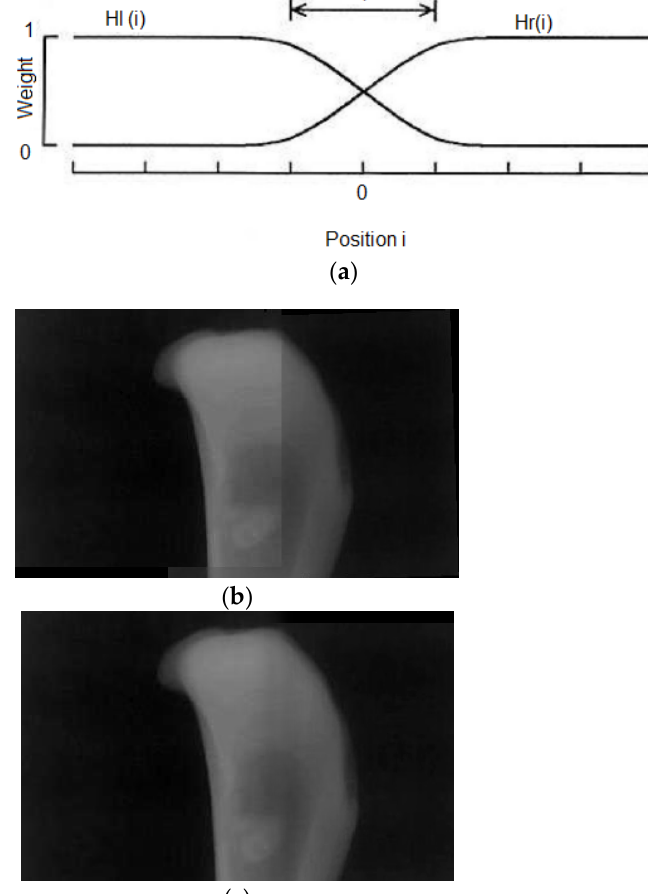
Figure 5. Image stitching; ( a ) Weight function; ( b ) Before image stitching ( c ) Results of image stitching.